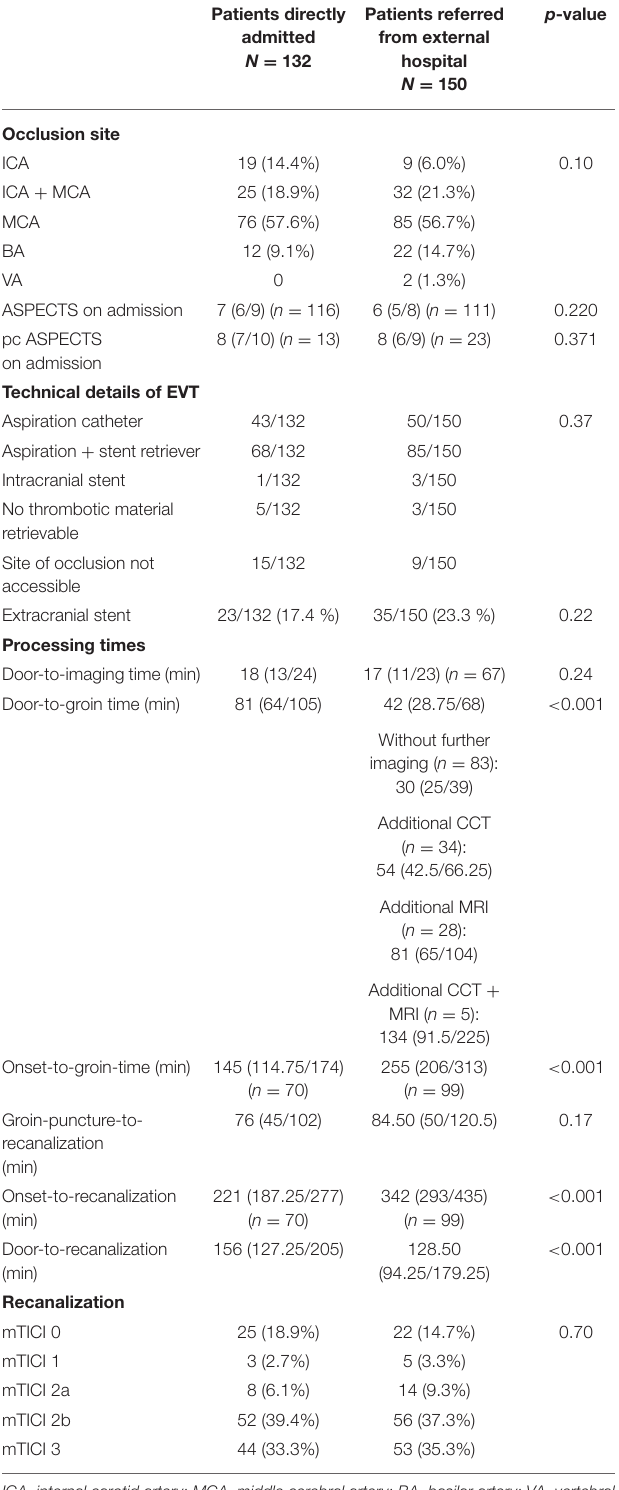
TABLE 2 | Neuroradiological